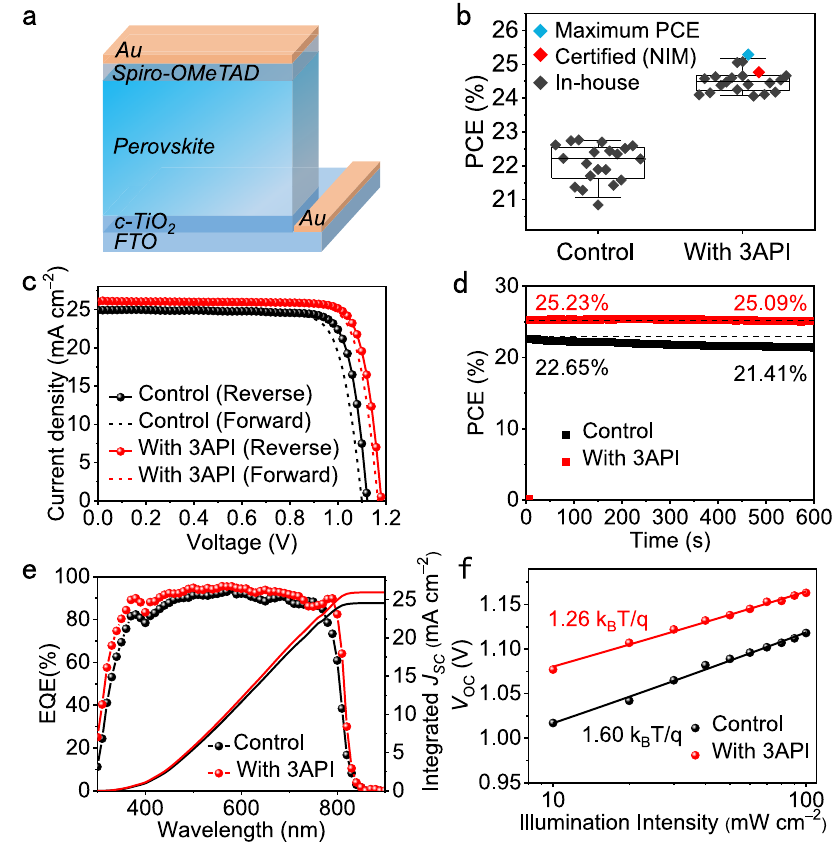
Fig.2|PhotovoltaicperformanceofthePSCswithout(denotedascontrol)and with 3API. a Planar n-i-p device structure. b Ef fi ciency statistics of both solar cells including the certi fi ed value obtained at the National Institute of Metrology (NIM)